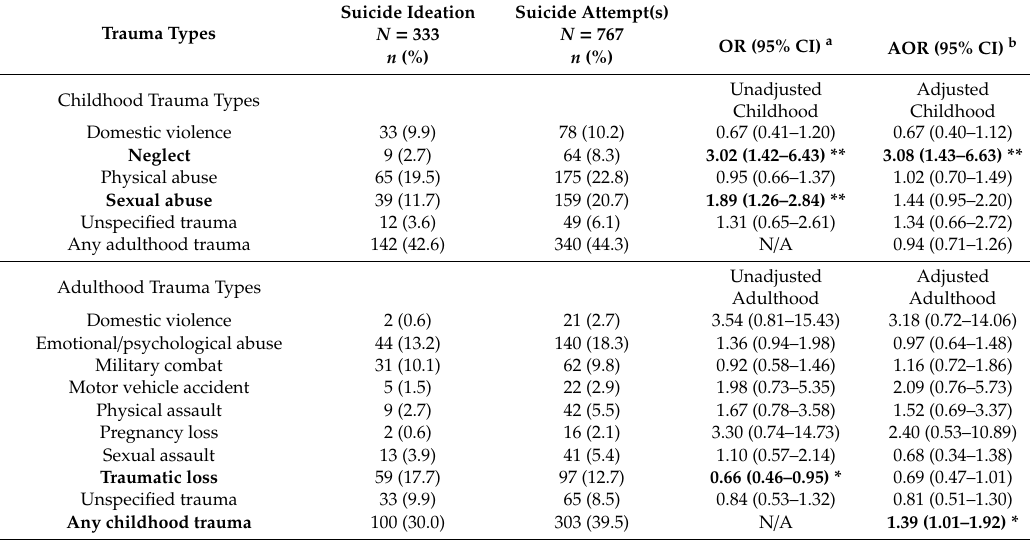
Table 3. Odds of psychiatric hospitalization for suicide attempt vs. suicide ideation for patients with each documented lifetime trauma exposure compared to patients without corresponding trauma experience ( N =